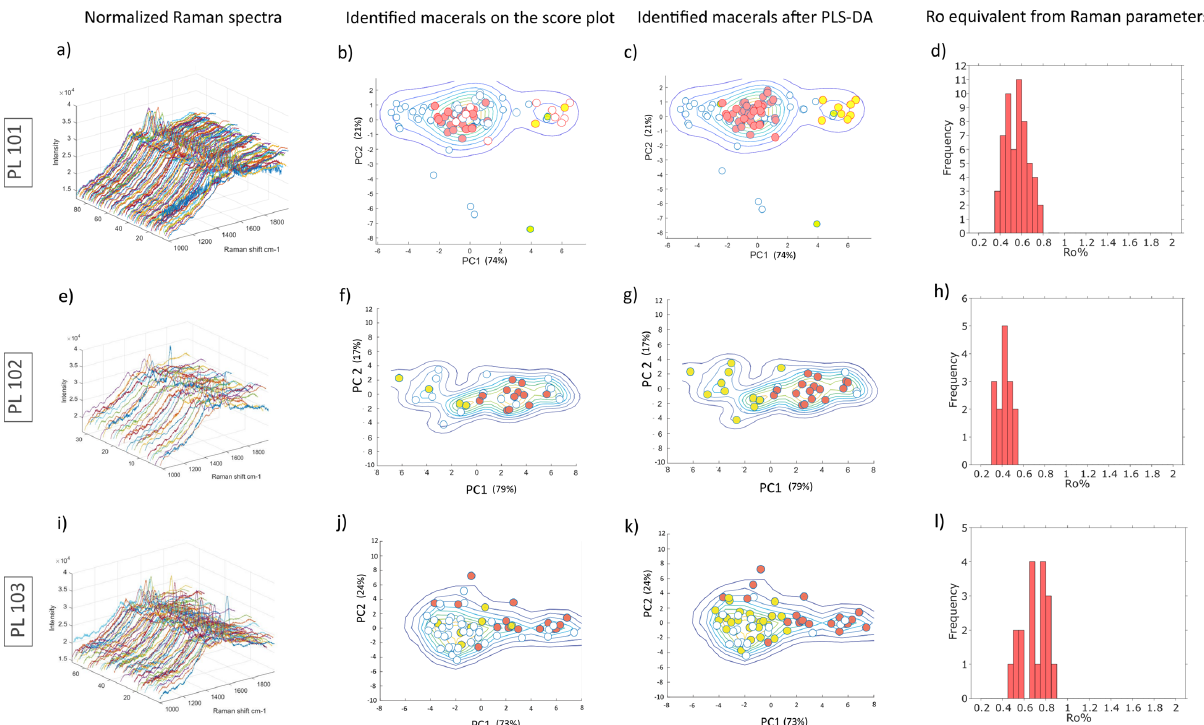
Figure 7. Results for samples PL 101, PL 102 and PL 103. Figures ( a , e , i ) show the raw spectra in a 3D view. Figures ( b , f , j ) the score plots distribution: red dots indicated optically recognized vitrinite while yellow dots optically recognized inertinite. Figures ( c , g , k ) show optically recognized and identified after PLS-DA vitrinites (red dots) and inertinites (yellow dots); number in brackets refers to explained variance by each principal component. Figures ( d , h , l ) show the histograms of R o % equivalent values from Raman parameters calculated on vitrinite recognized by means of PLS-DA.